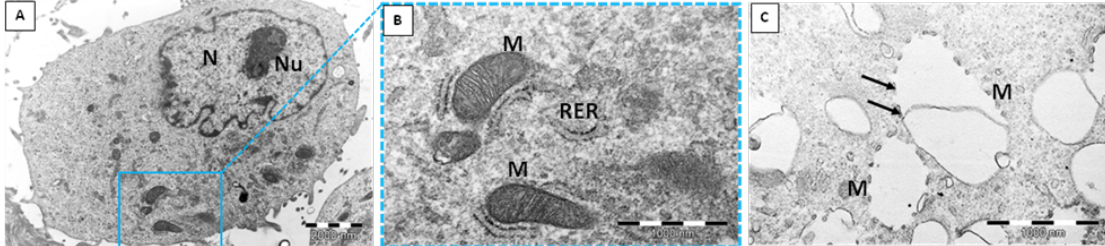
Figure 4. Control group cells. Proper ultrastructure without signs of cell death is distinct ( A , B ). For comparison, degenerated mitochondria after exposure to silica nanoparticles are depicted on ( C ). Arrows—remnants of damaged mitochondrial membrane. N—nucleus; Nu—nucleolus; M—mitochondria; RER—rough endoplasmic reticulum.